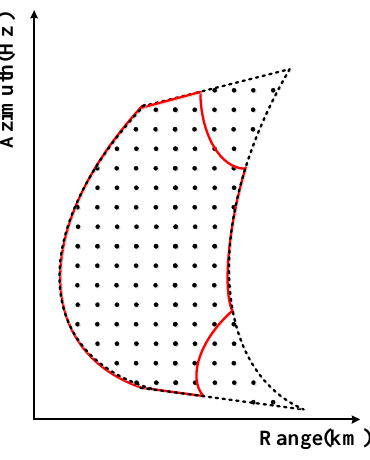
Figure 6. Simulated image using the former weighting method [26] with the deramping operation in the range time domain. The red line shows the residual spectrum in the range-Doppler domain after a deremping operation while using the former weighting method [26], and the dotted line shows the spectrum in the range-Doppler domain after a deremping operation without a weighting operation.